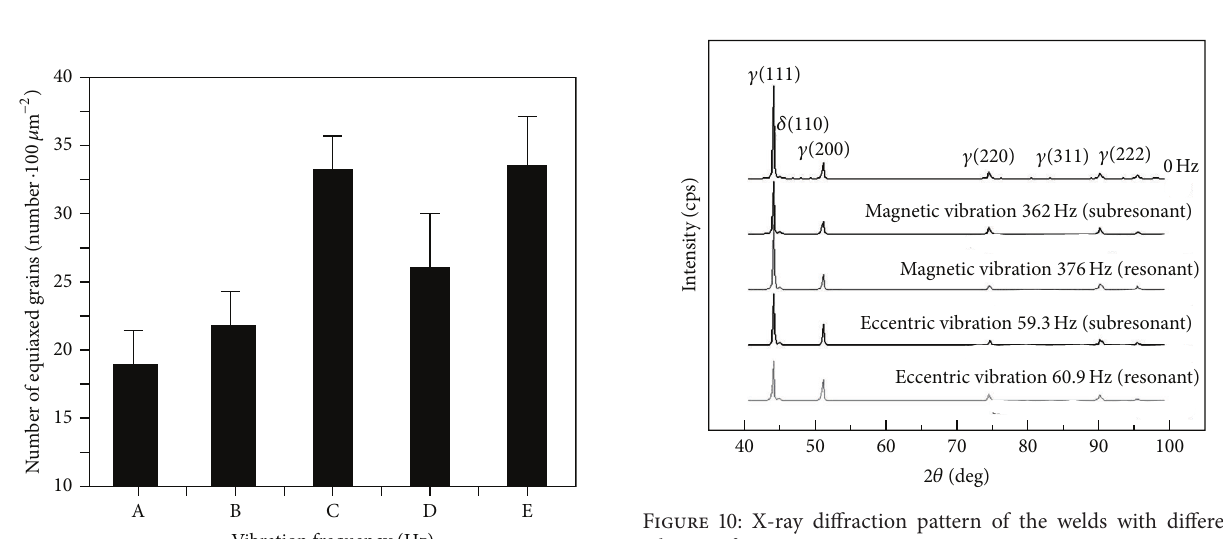
Figure 8: The microstructures in the center of the welds with various vibration frequencies: (a) 0Hz, (b) TX-VSR 362 Hz, (c) TX-VSR 375 Hz, (d) Meta-Lax 59.3 Hz, and (e) Meta-Lax 60.9 Hz.